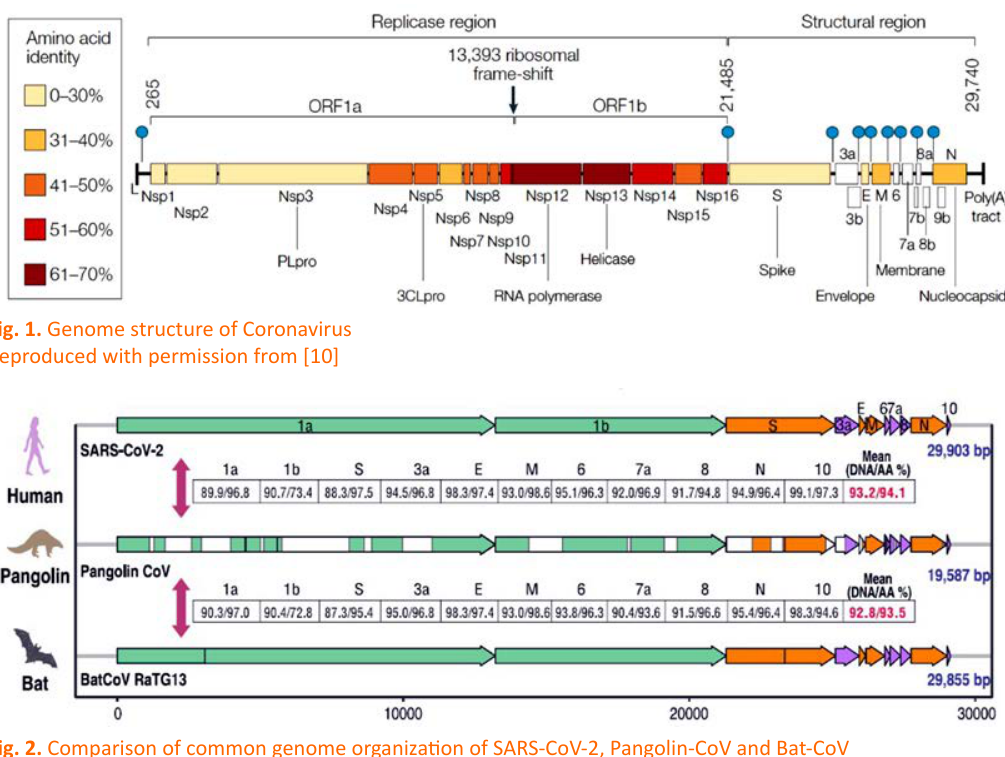
Fig. 2. Comparison of common genome organization of SARS-CoV-2, Pangolin-CoV and Bat-CoV Reproduced with permission from